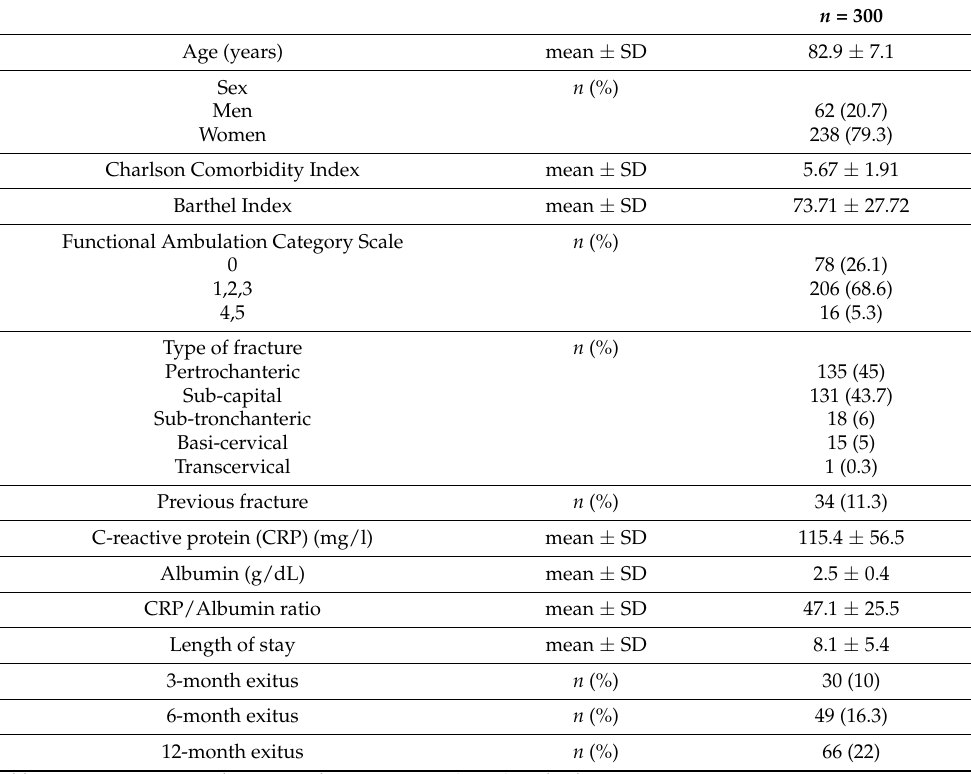
Table 1. General